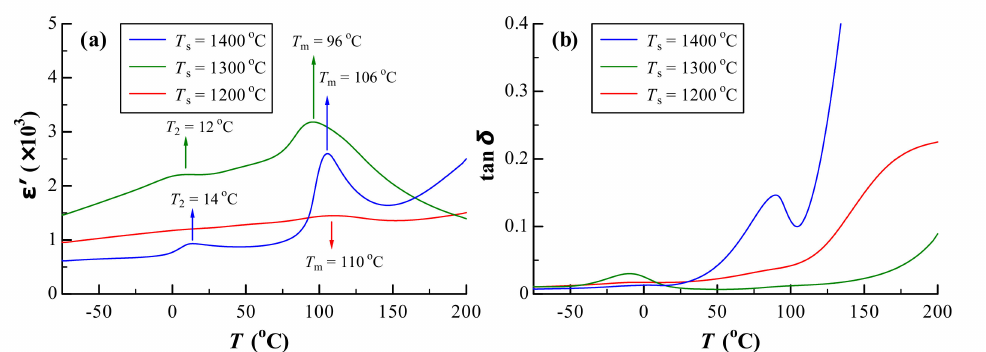
Figure 4. Temperature dependencies of ( a ) dielectric permittivity ( ε ’) and ( b ) dielectric loss (tan δ ) for BM1T sintered at T s = 1200, 1300, and 1400 ◦ C.